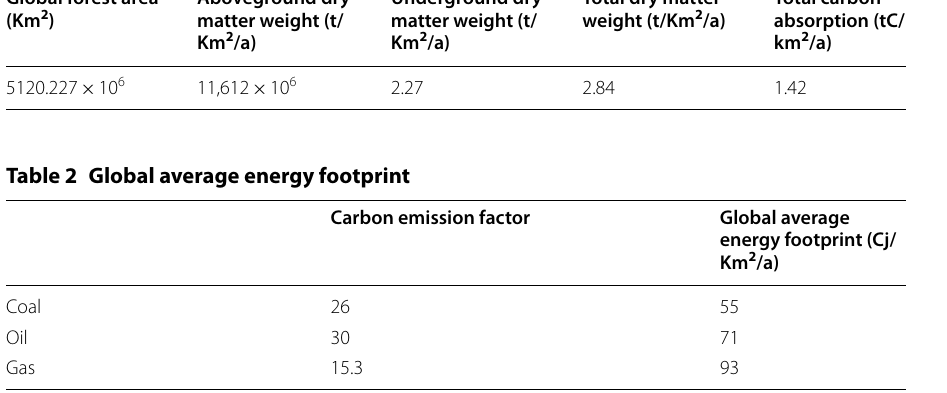
Table 1 Carbon uptake per unit area Global forest area (Km 2 )